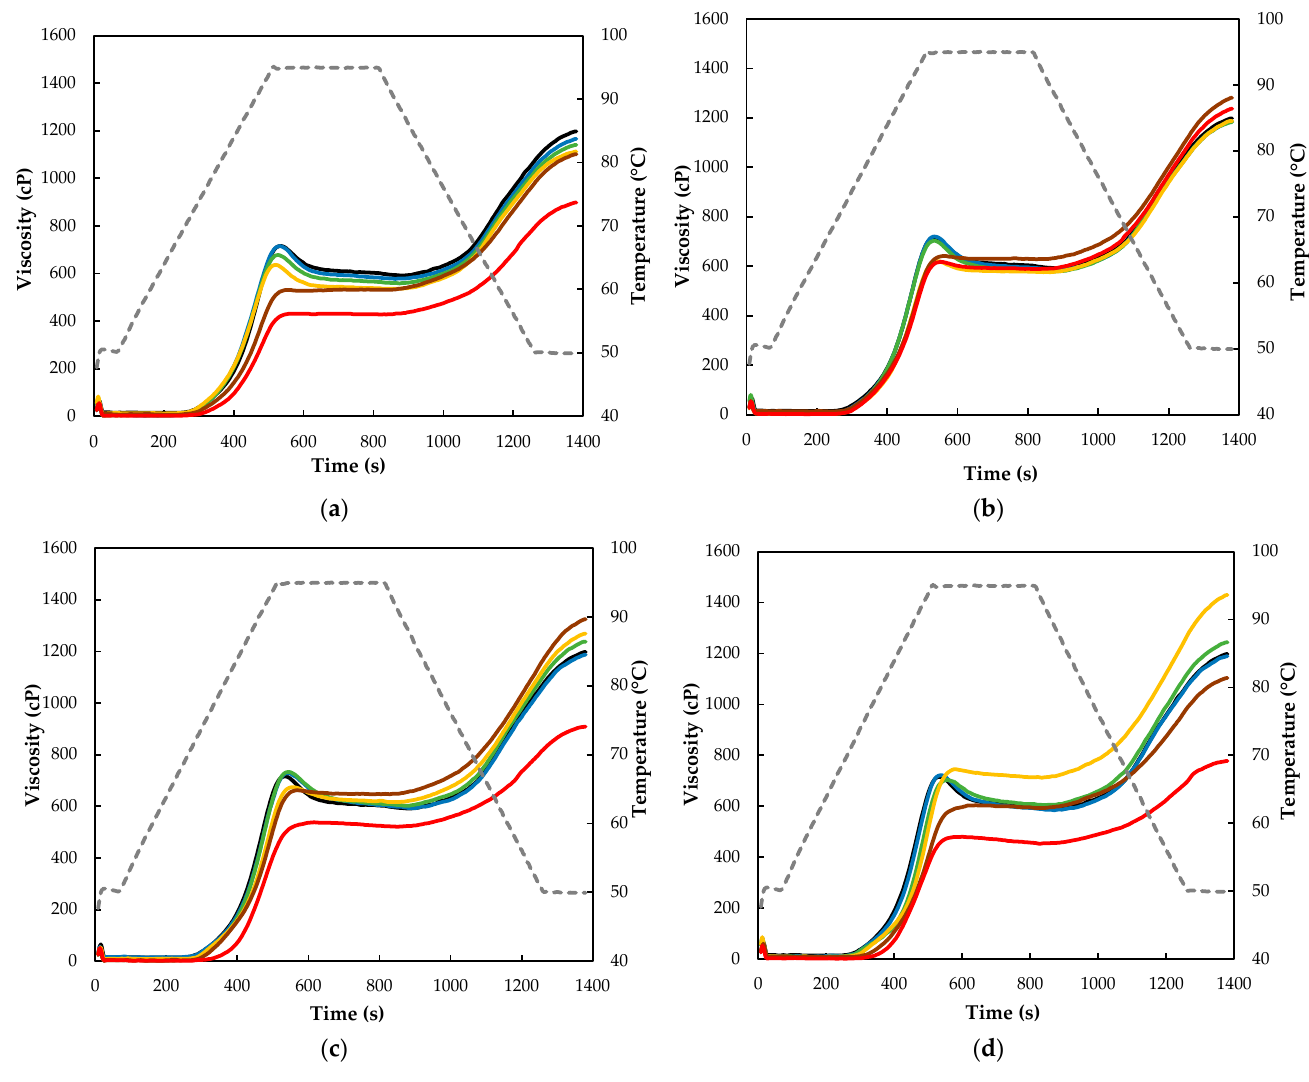
Figure 3. Pasting profiles of control and MW-treated brown tef flour at 12 ( a ), 15 ( b ), 20 ( c ), and 25% moisture content ( d ). tef flour native (control). Black, blue, green, yellow, brown, and red lines correspond to untreated, 1 min, 2 min, 4 min, 6 min, and 8 min treated samples, respectively, and grey discontinuous lines correspond to the temperature